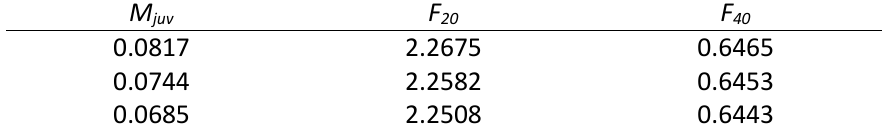
Table 51. Reference points generated from horseshoe crab egg-per-recruit models for the Delaware Bay population under varying levels of juvenile natural mortality ( M juv ).